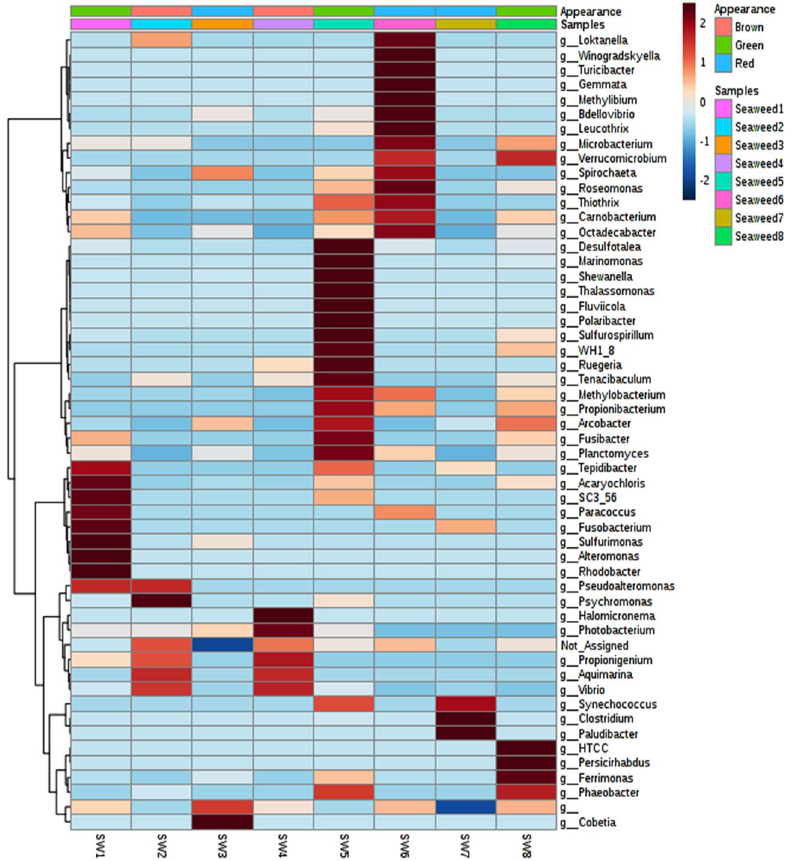
Figure 4. Genus level distribution of epiphytic bacterial communities on different seaweed leaf samples.